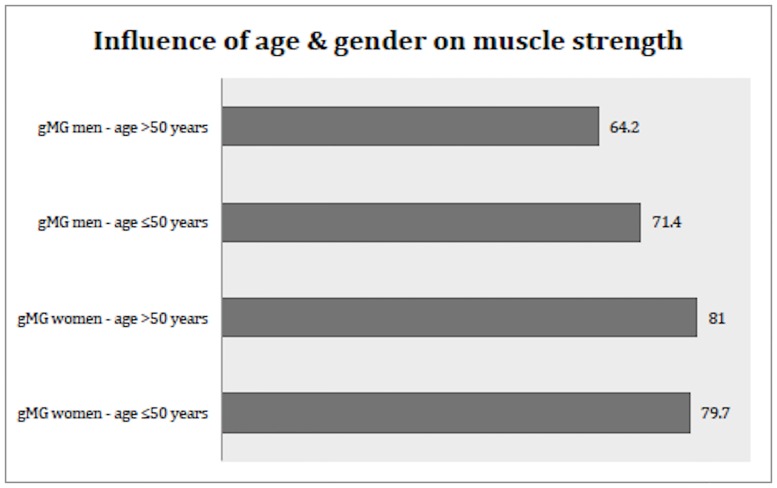
Influence of age and gender on muscle strength in generalized myasthenia gravis.Total composite strength in mysthenic male and female patients under or older than age 50 years, expressed as percentage of normal strength in healthy age- and gender-matched subjects.